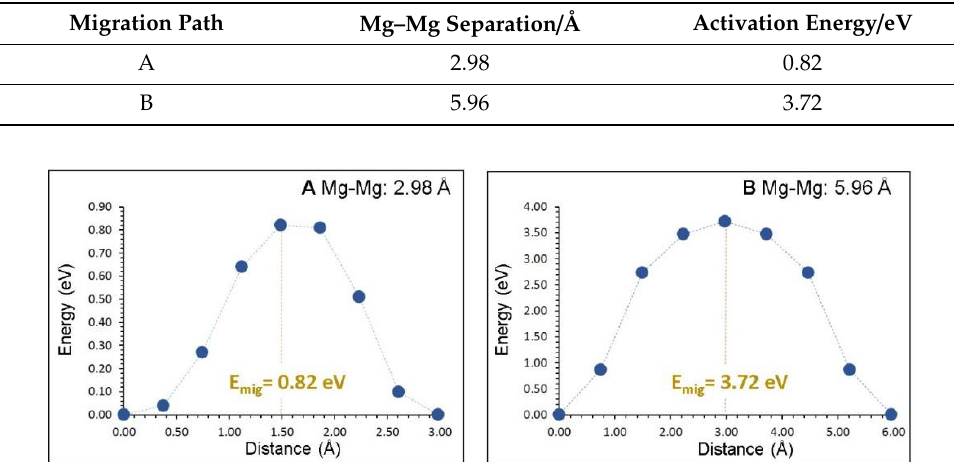
Table 2. Calculated Mg–Mg separations and activation energies for the magnesium ion di ff usion between two adjacent Mg sites (refer to Figure 3).